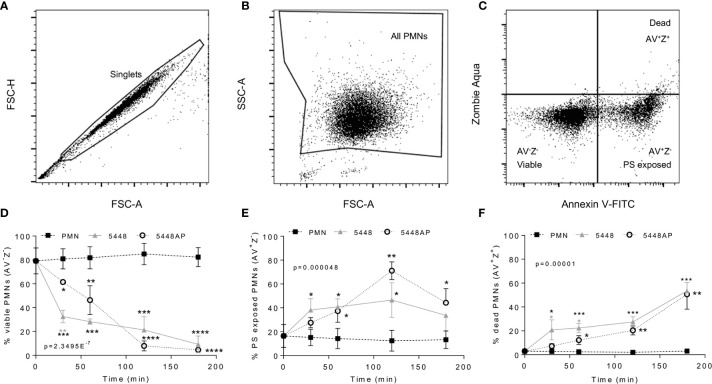
Group A Streptococcus (GAS) infection induced neutrophil death. Human neutrophils (PMNs) were stained with Annexin V-FITC and Zombie Aqua Fixable Viability dye via flow cytometry and initially gated upon (A) ‘singlets’ (FSC-A vs. FSC-H, 10,000 events collected). ‘All PMNs’ (live and dead) were selected using (B) a gate excluding GAS. Cells were then compared for fluorescence of (C) annexin V-FITC/phosphatidylserine (PS) binding against Zombie live/dead viability dye. Purified PMNs were sampled over 180 min to measure (D), ‘viable’ (AV-Z-), (E) ‘PS exposed’ (AV+Z-) and (F) ‘dead’ (AV+Z+), neutrophils during GAS infection (n=3 donors). Results are pooled means ± SD. Linear mixed model ‘p’ values represent interaction (treatment*time) or are stated. *p<0.05, **p<0.01, ***p<0.001 and ****p<0.0001, with black asterisks denoting significance from control and grey asterisks between 5448 and 5448AP.